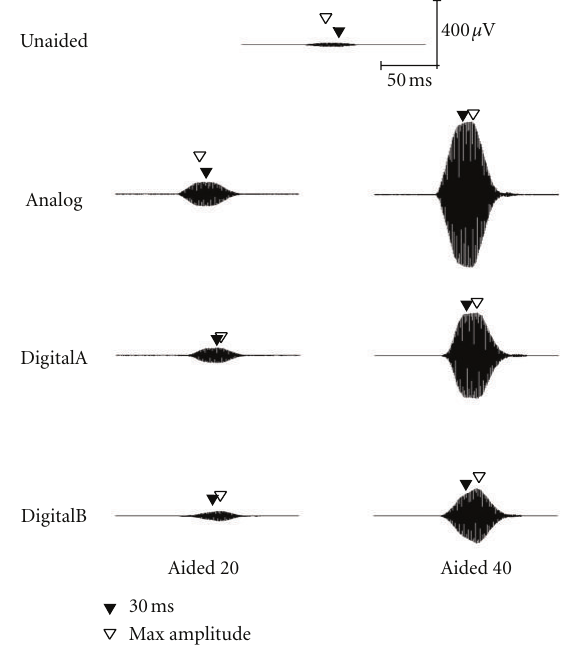
Figure 2: Waveform of the short stimulus presented at 50dB SPL as measured in the ear canal of a single representative subject (subject